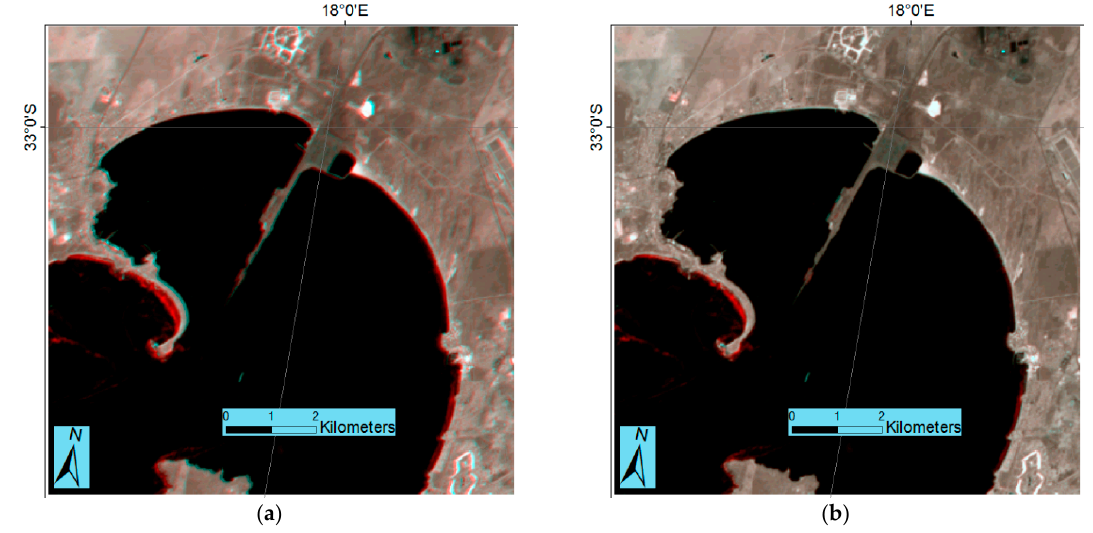
Figure 6. False color images illustrating Landsat-8 week 47 and Sentinel-2A week 51 images ( a ) before registration and ( b ) after registration. The Sentinel NIR data are shown as red and the Landsat NIR data are shown as blue and green. A 350 × 350 30 m pixel subset over Saldanha Bay, Cape Town (northern side of the WELD tile, Figure 1) is shown. The registration was undertaken using the affine transformation coefficients (Table 3).